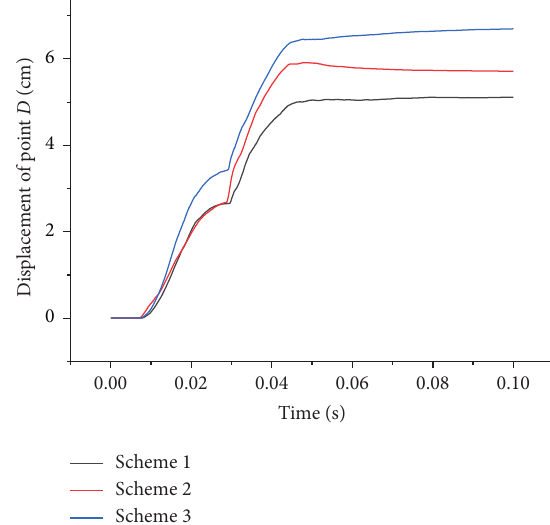
Figure 14: Displacement of the bench back.